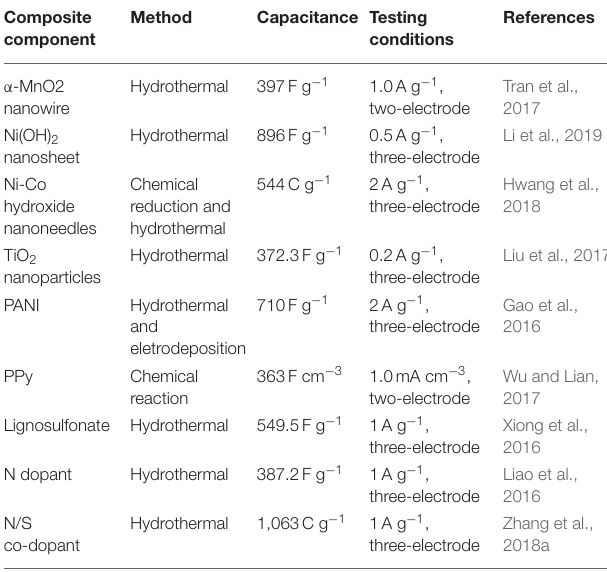
TABLE 1 | Characteristics of typical graphene-based composite hydrogel for supercapacitor